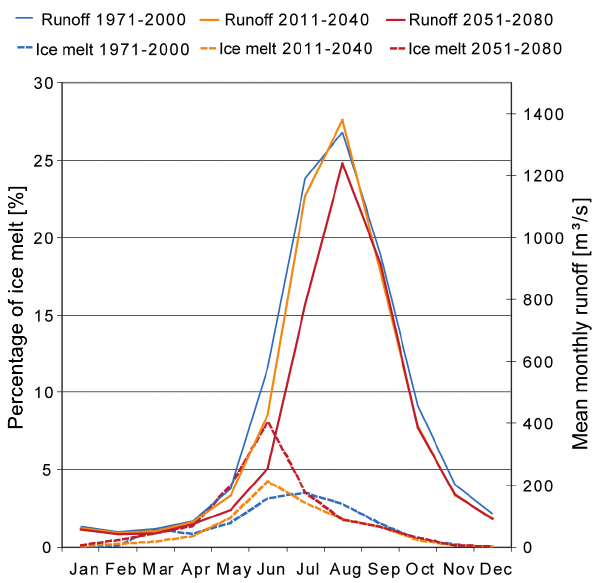
Figure 16. Development of the percentage of ice melt on the mean monthly discharge in the Lhasa River catchment for the 30-years- periods from 1971–2000, from 2011–2040 and from 2051–2080 according to the A1B